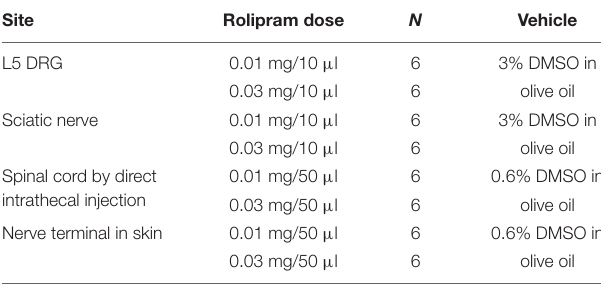
TABLE 1 | Local administration of